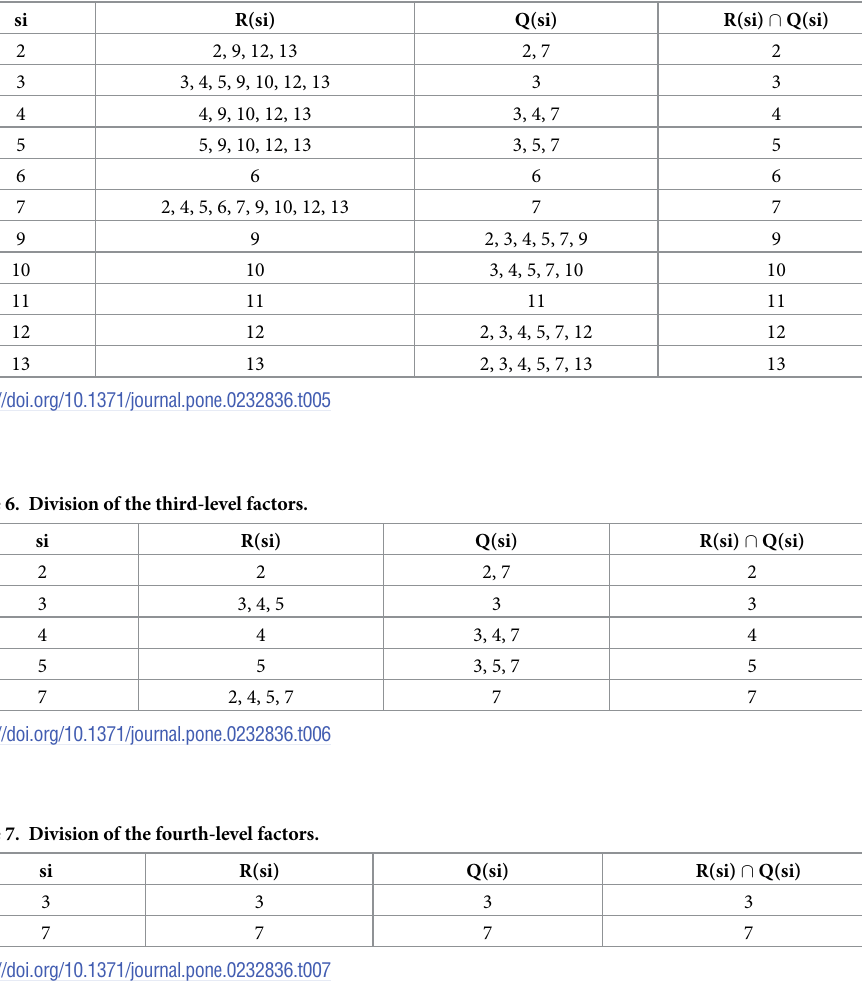
Table 5. Division of the second-level factors.